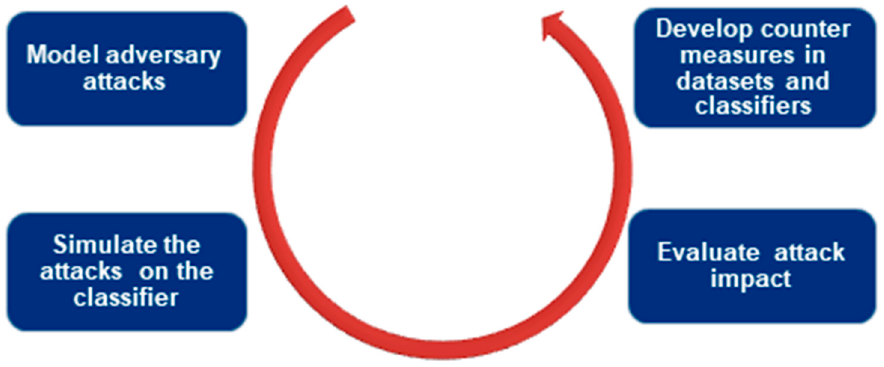
Figure 5. Proactive approach to machine learning attacks.